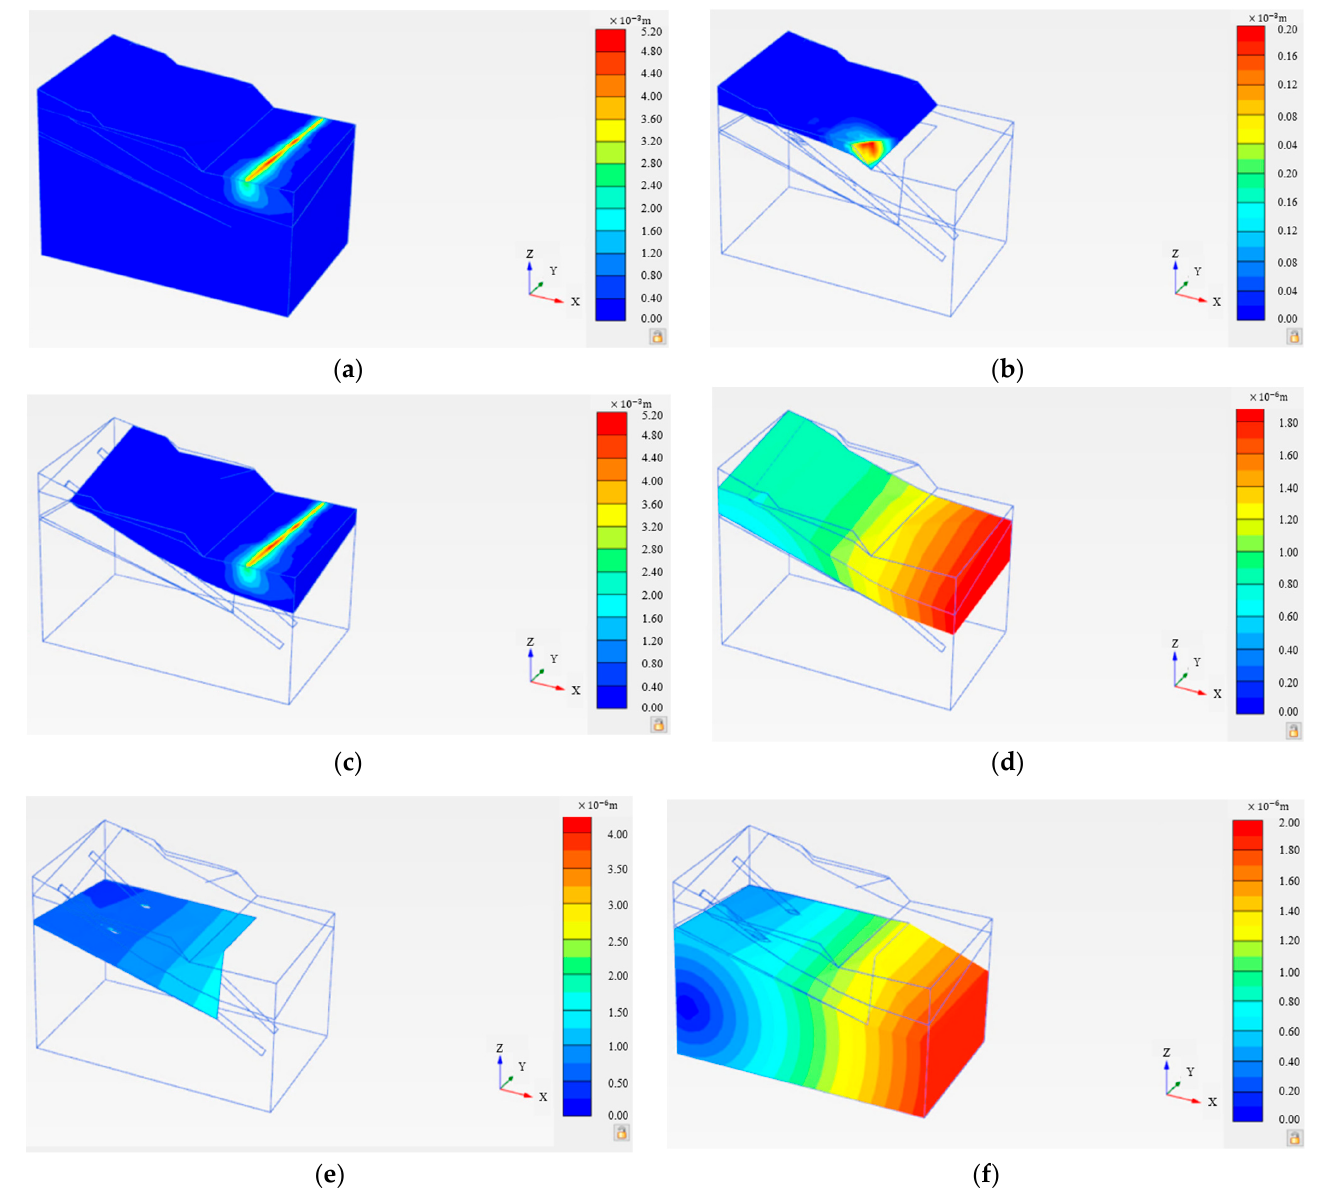
Figure 14. The displacement of slope. ( a ) Overall slope displacement; ( b ) mixed fill layer displacement; ( c ) gravelly soil displacement; ( d ) upper displacement of the epidote; ( e ) epidote weak layer displacement; and ( f ) sandstone displacement under the epidote.